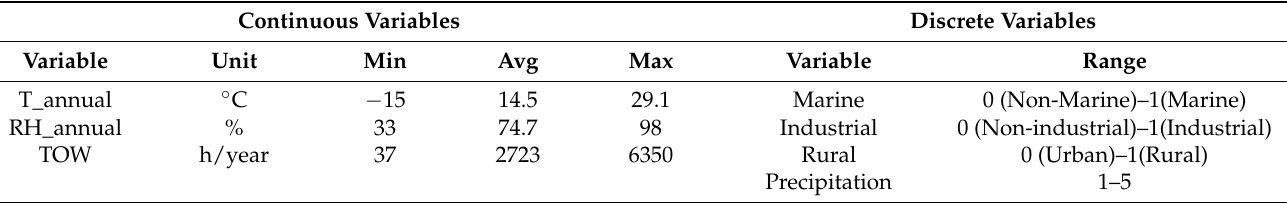
Table 2. Information on new continuous and discrete variables